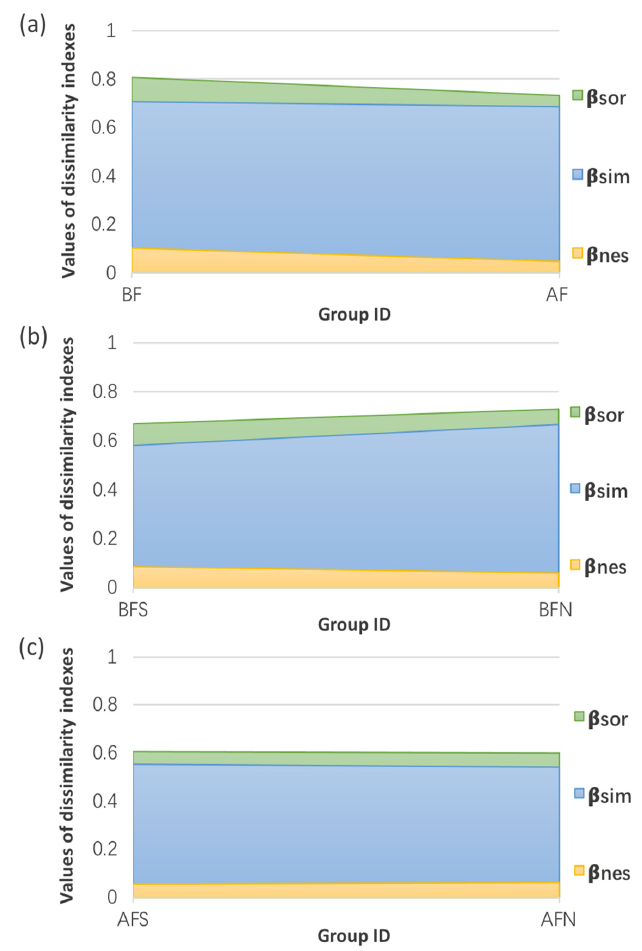
Figure 7. β -diversity pattern indexes of eukaryotic communities ( a ) before and after the floods (BF represents samples collected before the floods; AF represents samples collected after the floods); ( b ) in the southern and northern parts of the sampling sites before the floods (BFS represents samples collected in the southern part of the sampling sites before the floods; BFN represents samples collected in the northern part of the sampling sites before the floods); ( c ) in the southern and northern parts of the sampling sites after the floods (AFS represents samples collected in the southern part of the sampling sites after the floods; AFN represents samples collected in the northern part of the sampling sites after the